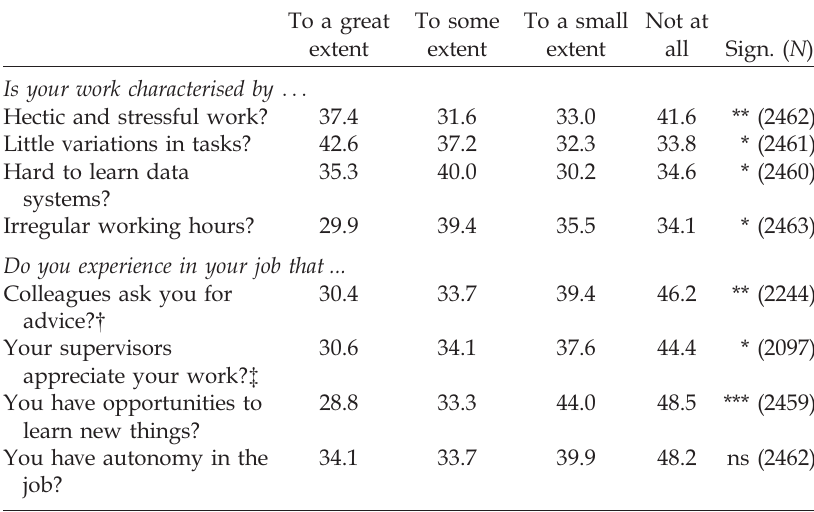
Table 5. Proportion experiencing declining work ability o v er the last ten years among employed persons aged 40 (cid:1) 69 years Psychosocial work en v ironment v ariables. NorLAG. Percentage. ( N